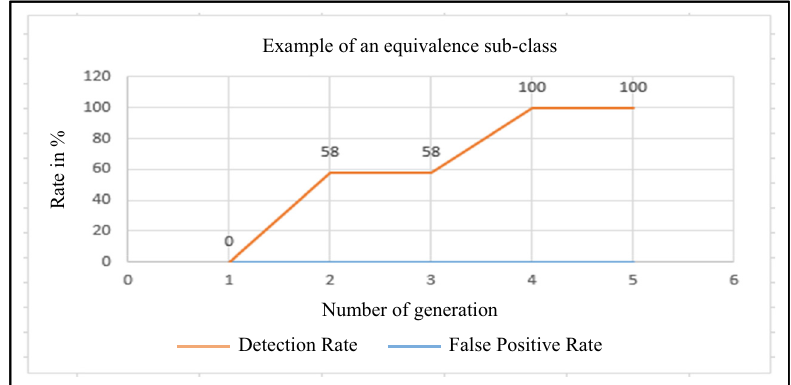
Figure 8: Detection result curve for an example of an equivalence subclass.